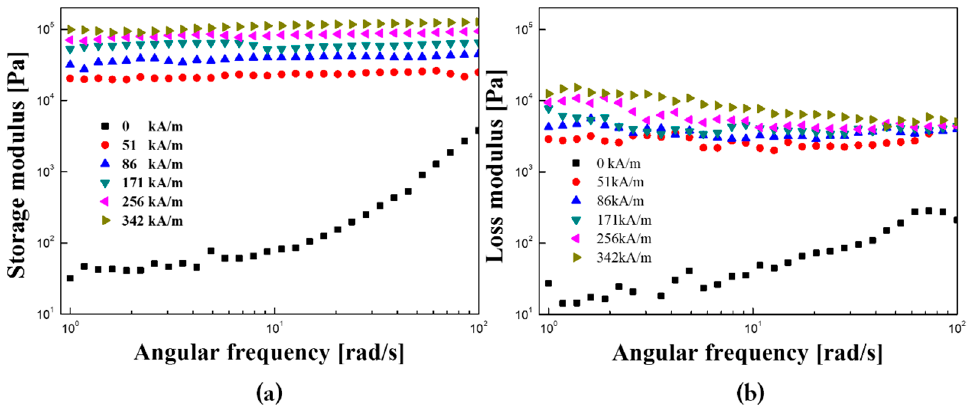
Figure 10. ( a ) Storage modulus; ( b ) loss modulus for core-shell microspheres Fe 3 O 4 /POA (10 vol %) MR suspension under various magnetic field strengths.